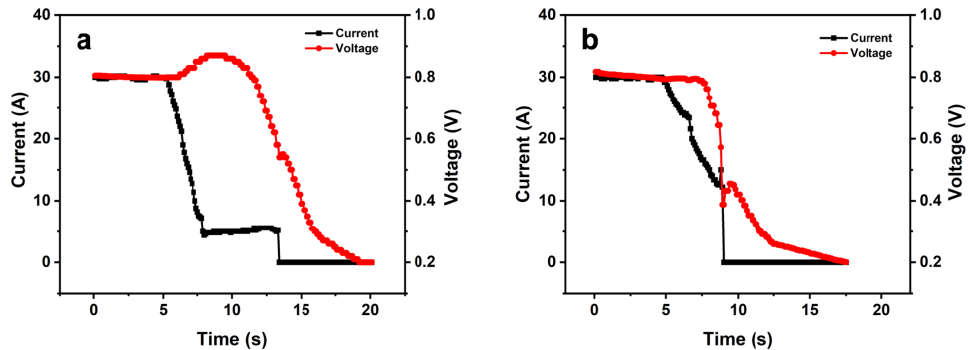
Figure 5. The relationship between the current and voltage of the PEMFC during the shutdown process at a discharge current drop rate. ( a ) 10 A/s, ( b ) 5 A/s.